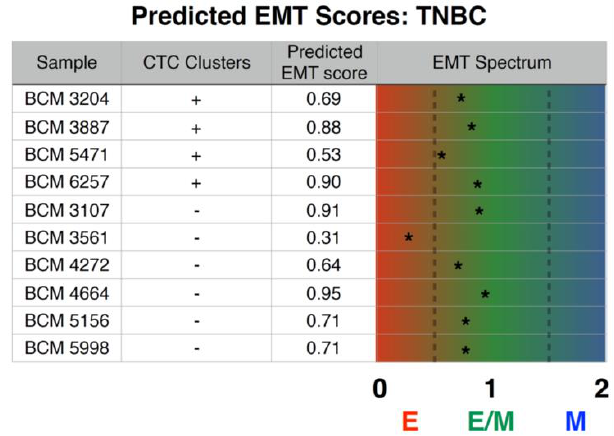
Figure 4. Inferential epithelial-mesenchymal transition (EMT) metric assigned to TNBC PDX models. This metric considers a set of EMT-relevant predictor transcripts and a cross-platform normalizer transcript set and uses it to probabilistically categorize samples into epithelial (close to 0), mesenchymal (close to 2), or hybrid E/M (close to 1).